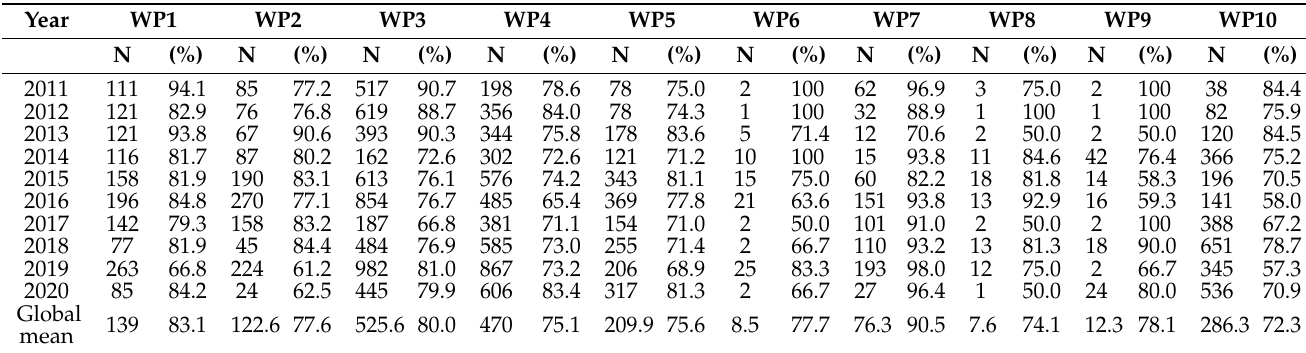
Table 3. Annual recorded negative lightning strikes per wind park presented as actual numbers (N) and as percentage of the total annual strikes (%) (observation period 2011–2020).